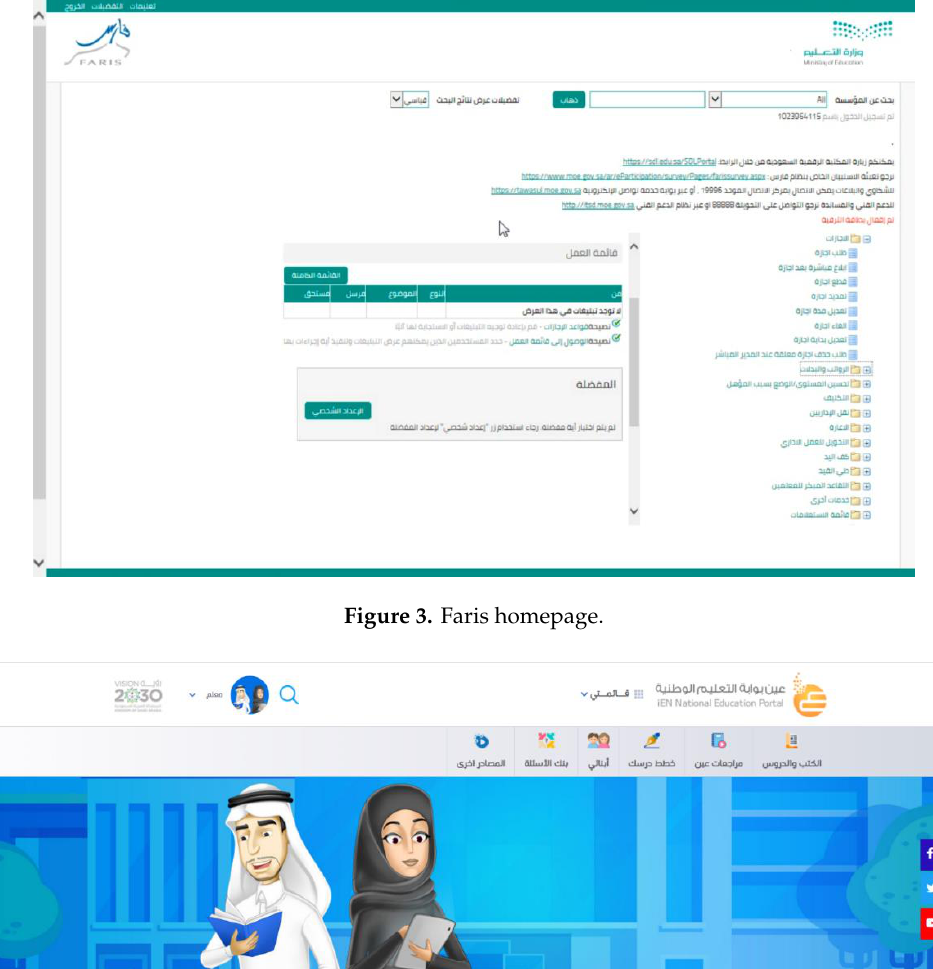
Figure 4. iEN homepage.